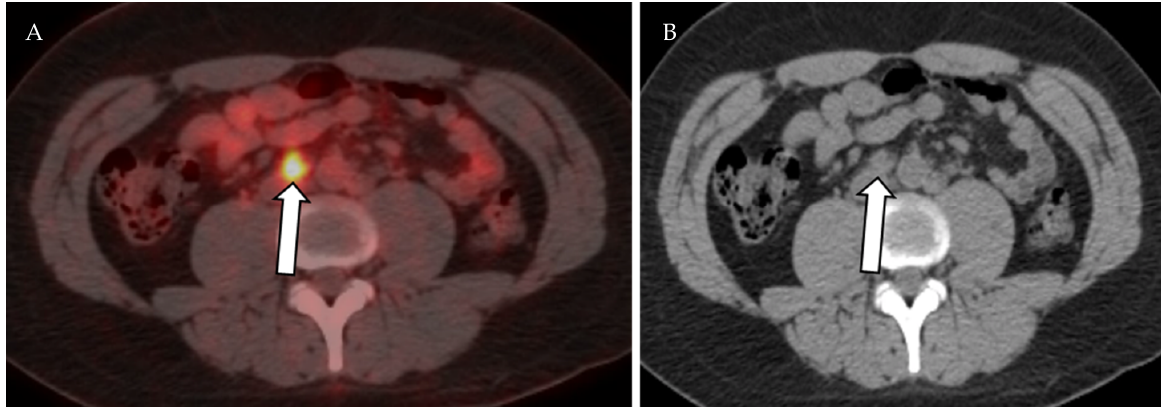
Figure 13. Axial fused PET-CT ( A ) and non-contrast CT of the abdomen shows mildly enlarged right paraaortic lymph node with increased FDG avidity on PET-CT (SUVmax 5.7), ( B ) biopsy proven Hodgkin lymphoma.